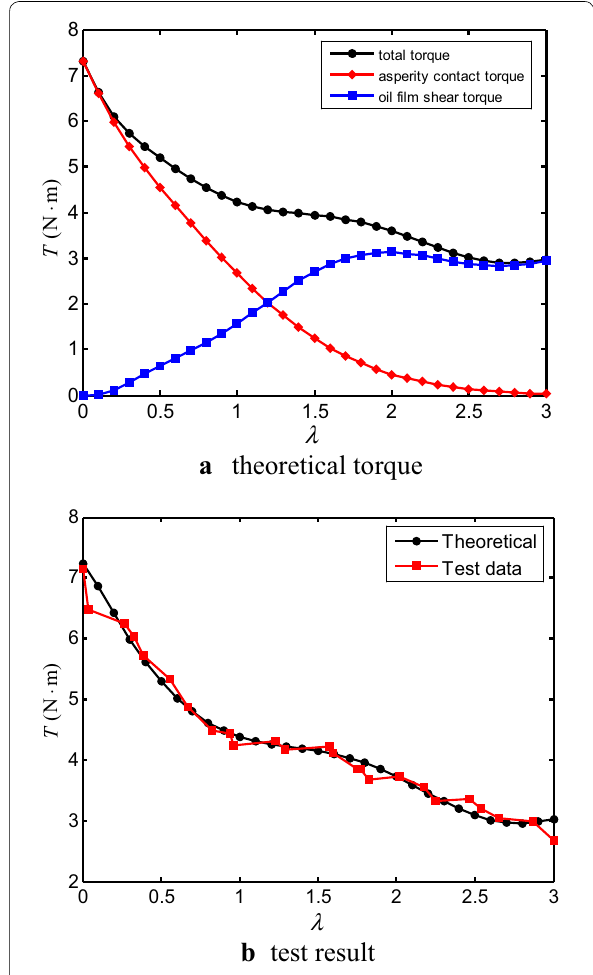
Figure 16 Variation of torque with film thickness